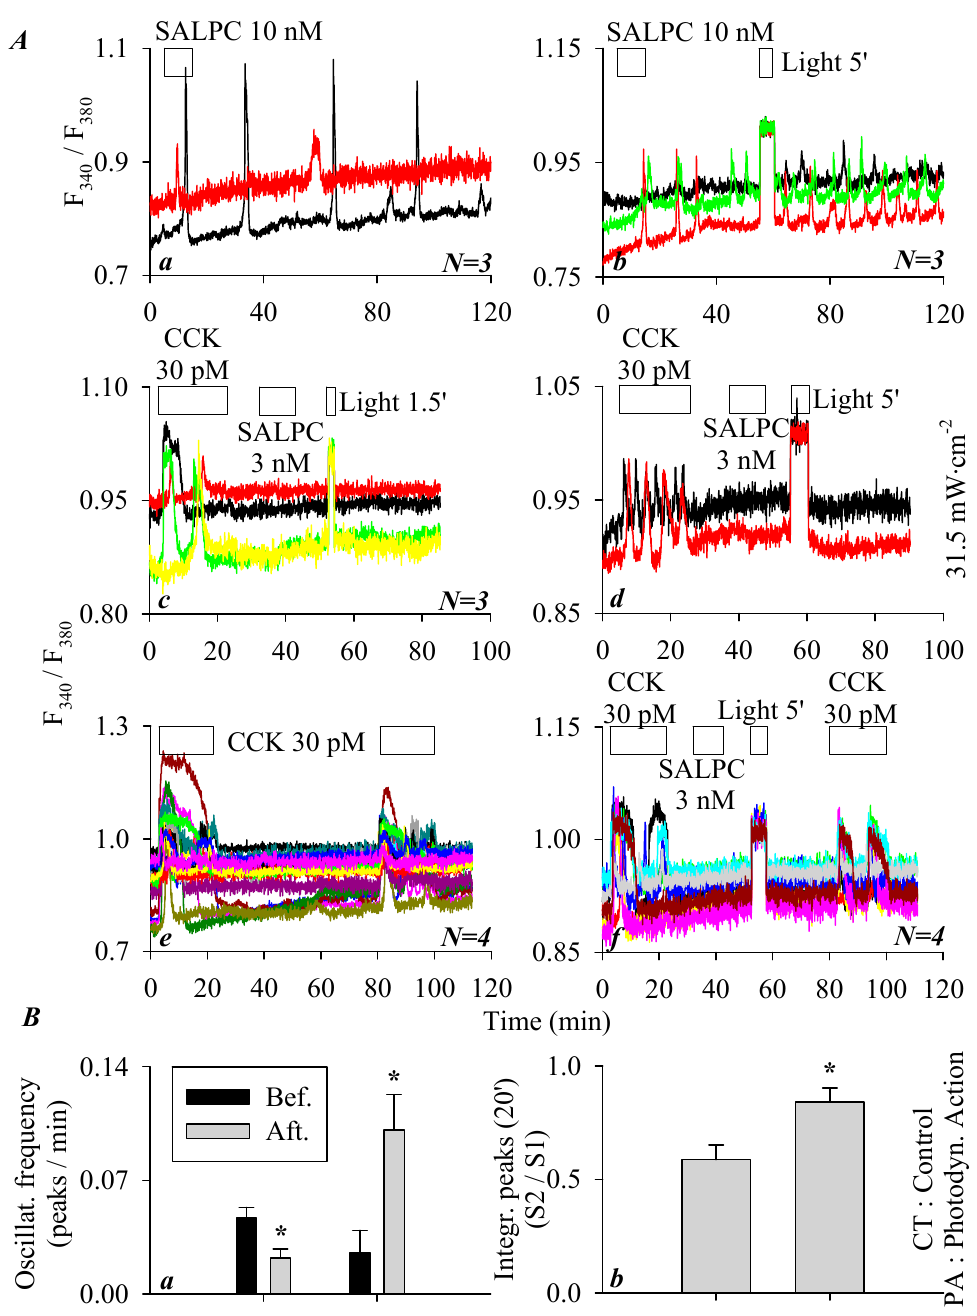
Figure 3. SALPC photodynamic sensitization of CCK2R in CCK2R-CHO-K1 cells. CCK2R-CHO-K1 cells loaded with Fura-2 AM were attached and perifused. CCK 30 pM and SALPC 3 or 10 nM and red light irradiation ( λ > 580 nm, 31.5 mW · cm − 2 ) were applied as indicated by the horizontal bars. ( Aa ) SALPC 10 nM, no light. ( Ab ) SALPC 10 nM, red light ( > 580 nm, 31.5 mW · cm − 2 , 5 min). ( Ac ) CCK 30 pM, SALPC 3 nM, red light ( λ > 580 nm, 31.5 mW · cm − 2 , 90 s). ( Ad ) CCK 30 pM, SALPC 3 nM, red-light irradiation ( λ > 580 nm, 31.5 mW · cm − 2 , 5 min). ( Ae ) CCK 30 pM. ( Af ) CCK 30 pM, SALPC 3 nM, red-light irradiation ( λ > 580 nm, 31.5 mW · cm − 2 , 5 min), CCK 30 pM. ( Ba ) The number of calcium peaks per unit time (calcium oscillation frequency) before illumination (5–55 min, Bef.), after illumination (60–110 min, Aft.), or during corresponding time periods without illumination was quantified. ( Bb ) The ratio of the calculated peak area above baseline (S2 / S1 of CCK stimulation) in ( Ae , Af ) is presented. Student’s t -test was done, statistically significant di ff erence is indicated by an asterisk (*) at p < 0.05. Representative calcium tracings from one of N identical experiments ( N = 3–4) are shown in ( Aa – Af